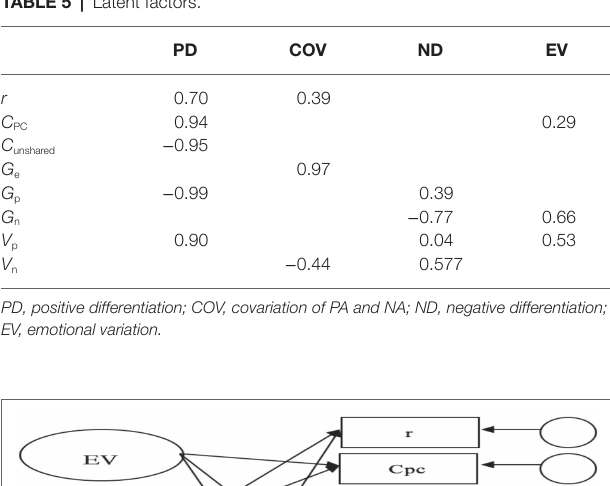
TABLE 6 | Frequency of important emotional